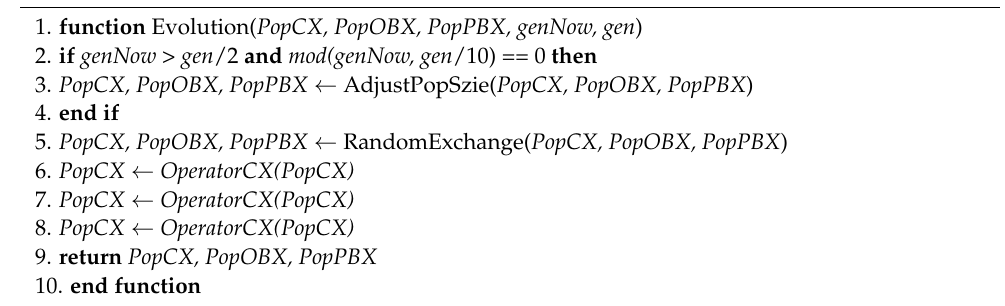
Algorithm 1: Evolutionary mechanism of the NSGA-III-COE.